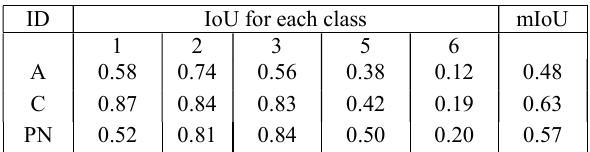
Figure 4. Classification by network with arrows showing the lo- cations of misclassification for (a) feature set C and (b) feature set A The arrow marked with (2) in Fig. 4b shows the misclassification of class 3 (High vegetation), for which almost all points are pre- dicted as class 5 (Building). This misclassification is largely re- duced with feature set C as shown by arrows marked with (2) in Fig. 4a. Similar to experiment 1, the misclassification at locations of geometry change is reduced when we consider NF with multi- ple search radii and NStat as shown by arrows marked with (1) in Fig. 4a and Fig. 4b. An occurrence of misclassification of class 2 (Natural terrain) into class 6 (Hard scape) is shown by arrows marked with (4) in Fig. 4. From the normalized confusion matrix, it can be seen that 4.10% of the points from class 2 got predicted as class 6.